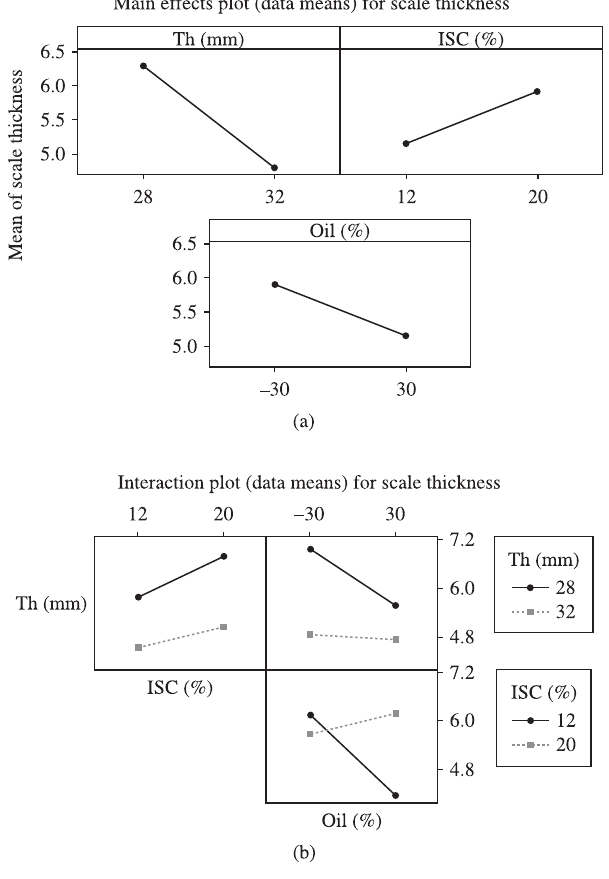
Figure 2. a) Effects of the processing parameters on the scale thickness; and b) effects of the interactions between the parameters on the scale thickness.